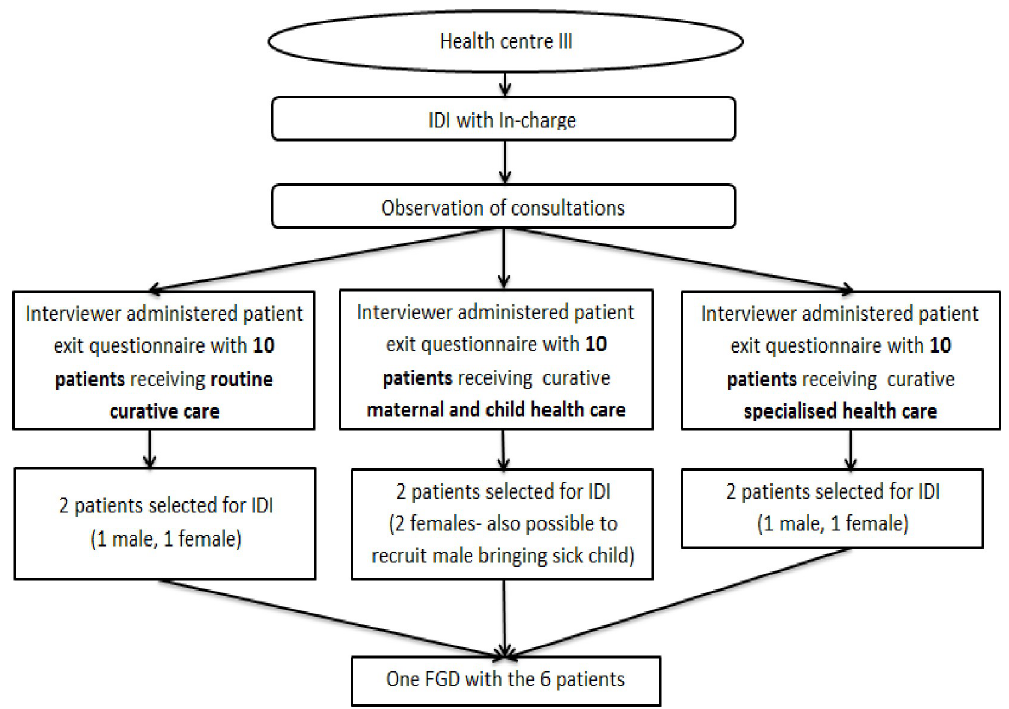
Fig 3. Selection of patients in each facility. A figure showing the process of selecting patients for exit interviews and follow- up in depth interviews and focus group discussions.